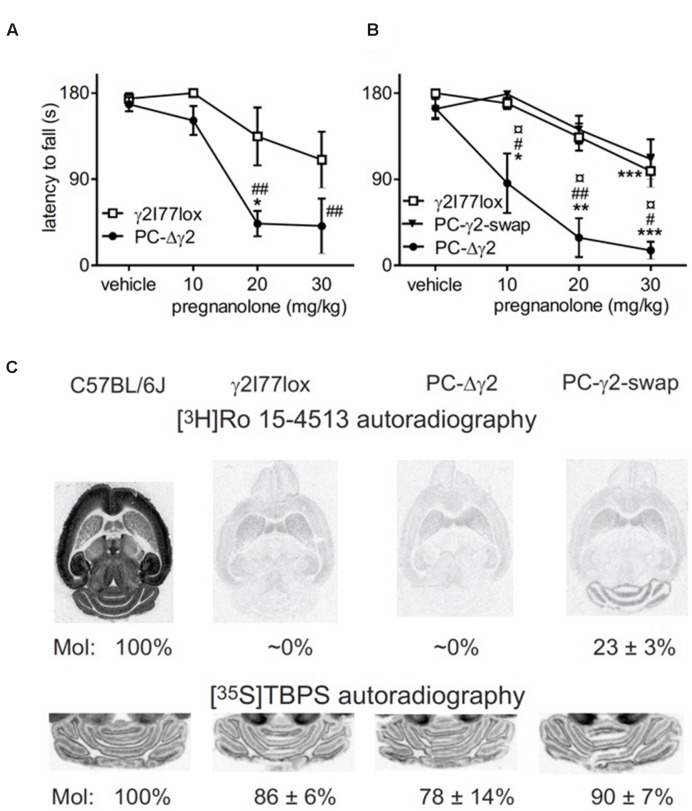
Neurosteroid sensitivity of PC-Δγ2 mice with targeted inactivation of GABAA receptor γ2 subunit gene in the cerebellar Purkinje neurons. (A) Effects of pregnanolone on motor performance. Pregnanolone was administered in cumulative doses (10+10+10 mg/kg i.p., total 30 mg/kg) to the control γ2I77lox (n = 5) and PC-Δγ2 (n = 5) mice, and the performance tested on accelerating rotarod (from 5 to 30 rpm) during 180 s. ANOVA followed by Newman–Keuls post hoc tests: ##P < 0.01 for the significance of the difference between the mouse lines, ∗P < 0.05 for the significance of the difference compared to vehicle within the PC-Δγ2 line. Data are presented as means ± SEM. (B) Effects of wildtype γ2 subunit rescue to the Purkinje neurons in PC-γ2-swap mice on pregnanolone sensitivity. Drug administration and testing of γ2I77lox (n = 10), PC-Δγ2 (n = 5) and PC-γ2-swap (n = 6) mice were carried out as in panel (A). ANOVA followed by Newman–Keuls post hoc tests: #P < 0.05, ##P < 0.01 for the significance of the difference between PC-Δγ2 and γ2I77lox mice. ¤P < 0.05 for the significance of the difference between PC-Δγ2 and PC-γ2-swap mouse lines. ∗P < 0.05, ∗∗P < 0.01, ∗∗∗P < 0.001 for the significance of the difference compared to vehicle injection within the mouse lines. Data are presented as means ± SEM. (C) Representative images of γ2 subunit-dependent [3H]Ro 15-4513 binding in normal wildtype C57BL/6J, γ2I77lox, PC-Δγ2 and PC-γ2-swap mouse horizontal brain sections, demonstrating a clear rescue of molecular layer binding in PC-γ2-swap mice. Please, note the very low binding in the forebrain regions in the brains with γ2I77lox background as compared to the wildtype brain. Representative cerebellar images of GABAA receptor ionophore binding sites labeled with [35S]TBPS show unchanged binding in genetically engineered mice.